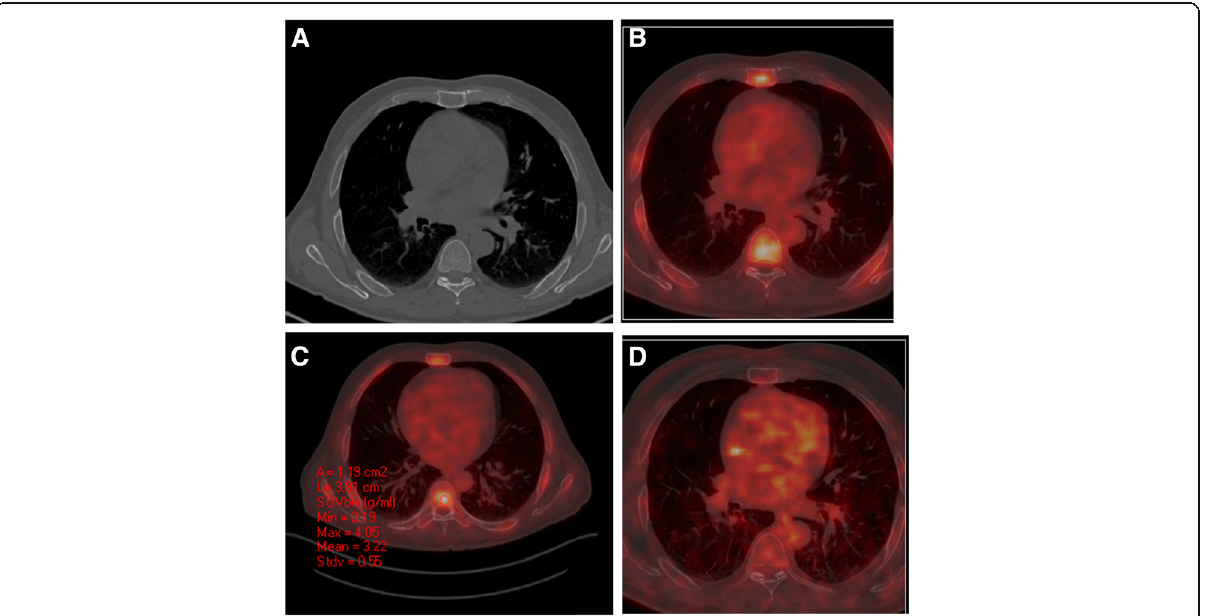
Fig. 2 A 56-year-old male patient with history of NHL. a Conventional CT study showing no gross lytic or sclerotic lesions noted within the sternum and DV5 body. b, c Corresponding PET/CT fused image shows focal FDG uptake in the sternum and DV5 vertebral body matching with radiologically occult bone marrow infiltration, SUV Max of the vertebral lesion: 4.05 d 7 months post treatment PET/CT fused image showing complete metabolic response with disappearance of the metabolically active bone marrow lesions by the visual assessment method